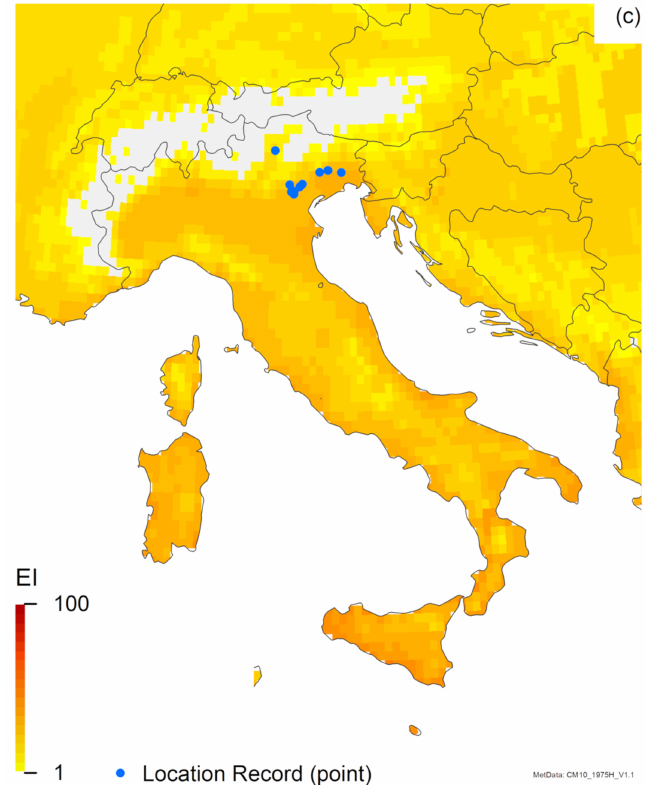
Figure 3. Modelled climate suitability (CLIMEX Ecoclimatic Index) for ( a ) Halyomorpha halys , ( b ) Trissolcus japonicus and ( c ) Trissolcus mitsukurii in Italy. Suitability for all three species is mapped as a composite of natural rainfall and irrigation based on identified irrigation areas